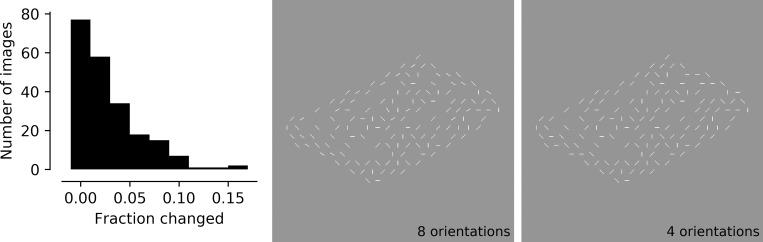
After the stimulus set was created, rare lines at orientations other than 0°, 45°, 90° or 135°were replaced.Left: in the majority of the images, fewer than 5% of the line segments were at 22.5°, 67.5°, 112.5° or 157.5°. These were therefore removed to simplify the final stimulus set. While observer ratings were performed on the images before the rare orientations were removed (8 orientations, middle panel), the changes were minor enough they would not be expected to change ratings by affecting perception of the object as a whole. See text for details.